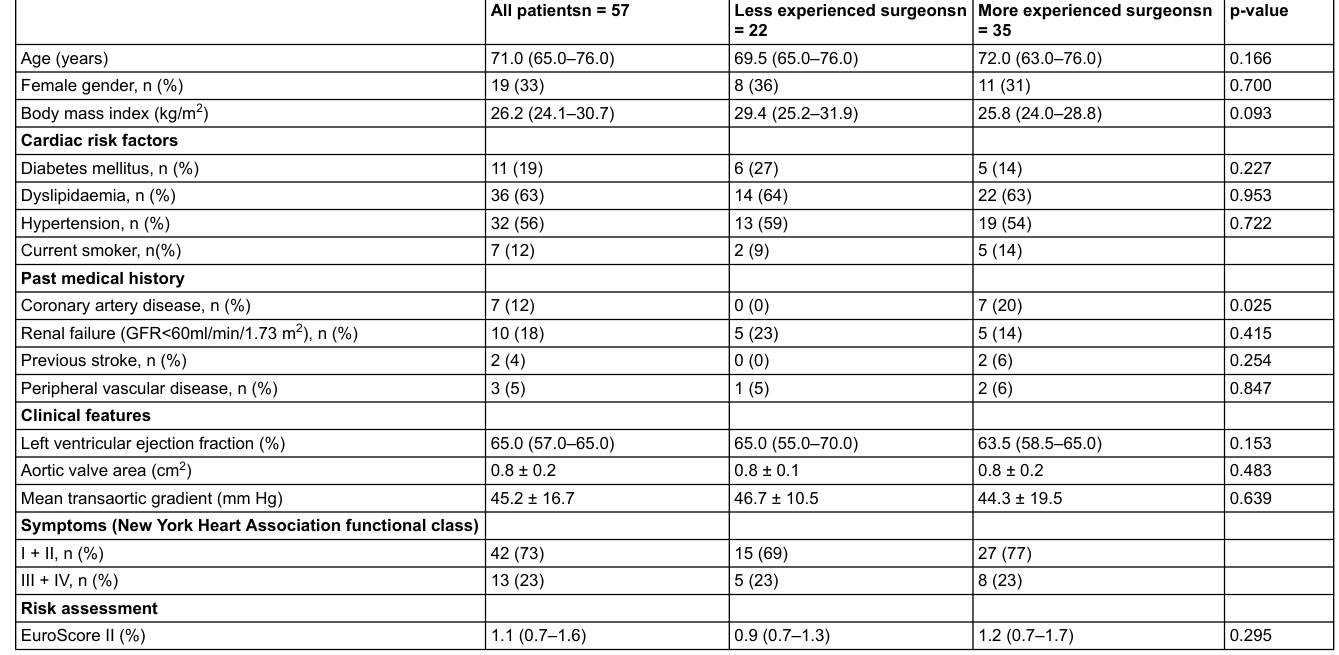
Table 1: Baseline clinical